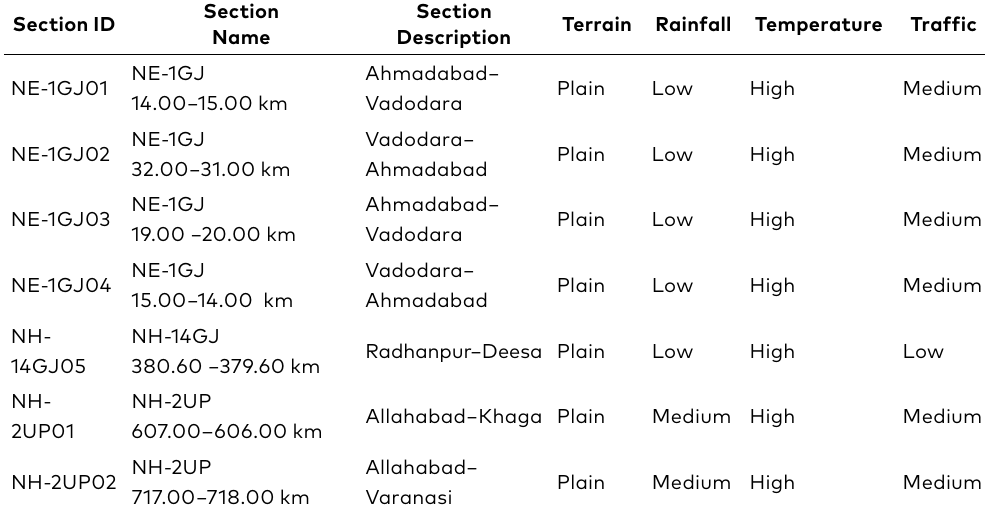
Table 1. Details of selected pavement